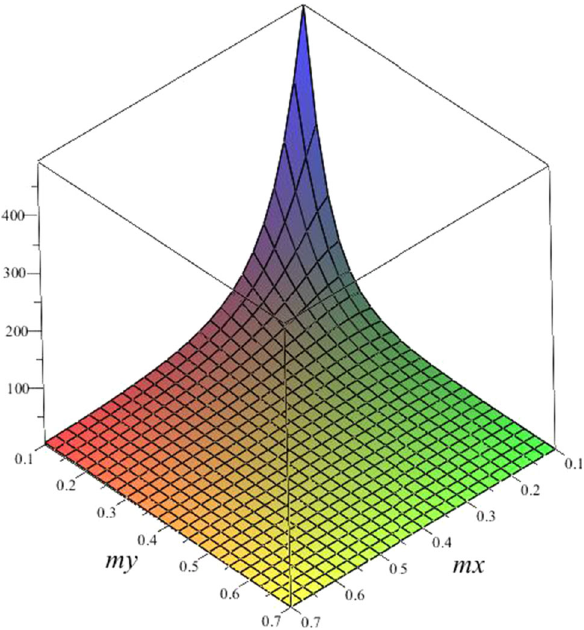
Fig. 6 Difference between the modulus of the electric field (43) and the modulus of the magnetic field (44) multiplied by 2 π/ m 2